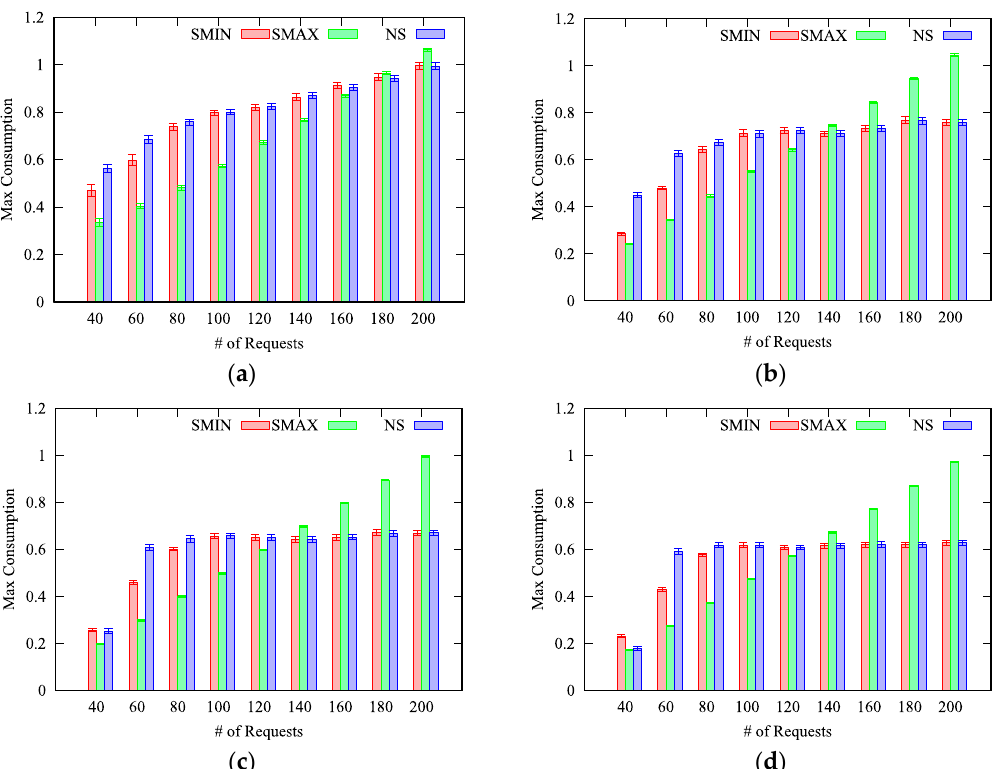
Figure 4. Max consumption: (a) Ratio 5%; (b) Ratio 25%; (c) Ratio 50%; (d) Ratio 75%.